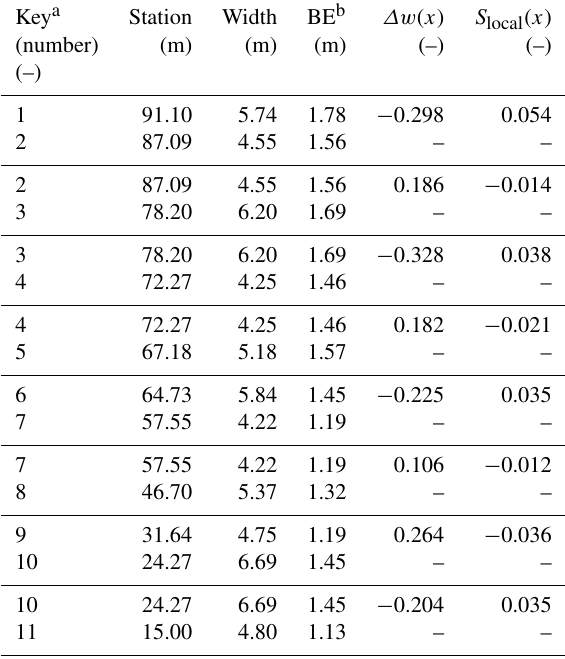
Table B1. Measurement details for Fig. 3 of Richards